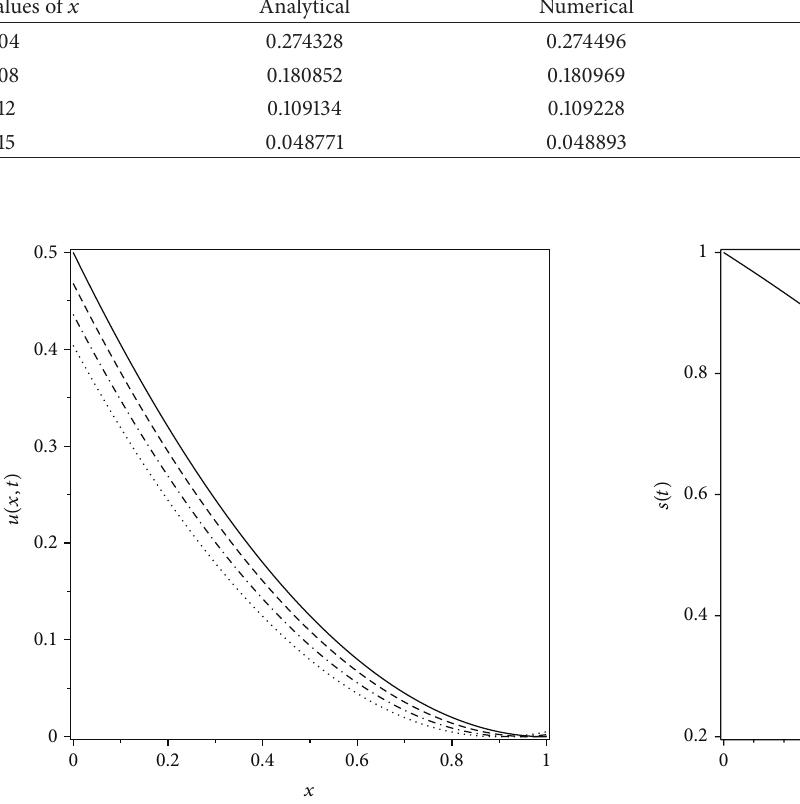
Figure 1: Concentration distributions 𝑢(𝑥,𝑡) for different values of 𝑡 . Solid line: 𝑡 = 0 , dashed line: 𝑡 = 0.01 , dash dotted line: 𝑡 = 0.02 , and dotted line: 𝑡 = 0.03 .